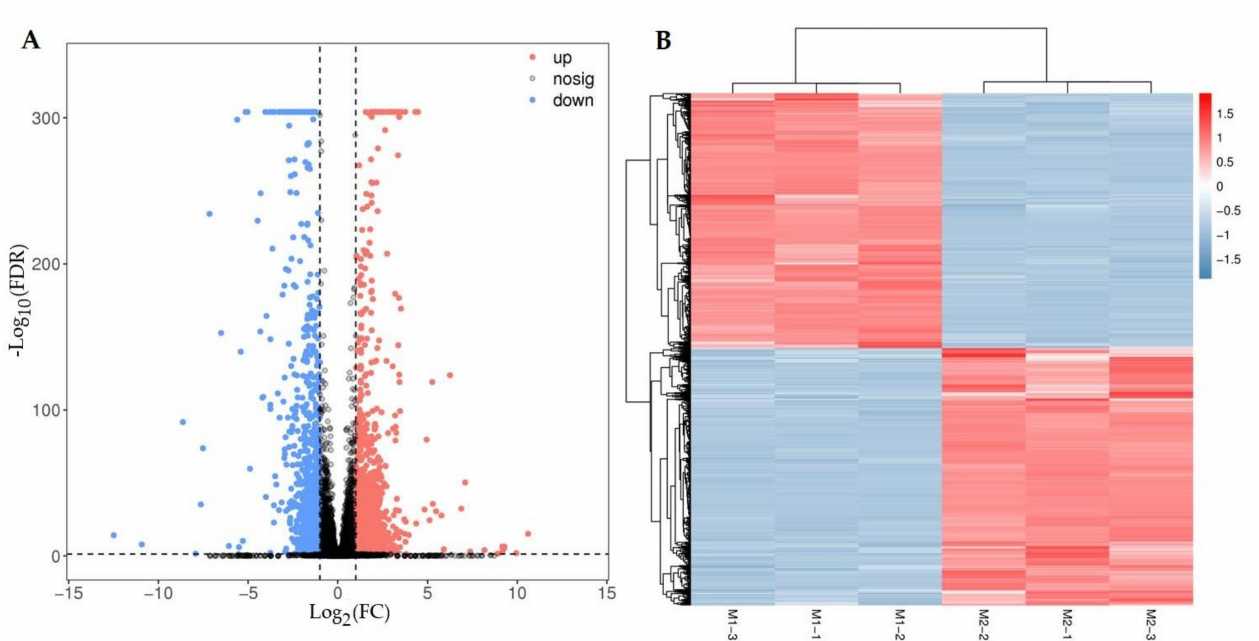
Figure 5. Volcano plot of differential comparison ( A ) and cluster heat map of the DEGs ( B ) in M1 vs. M2.